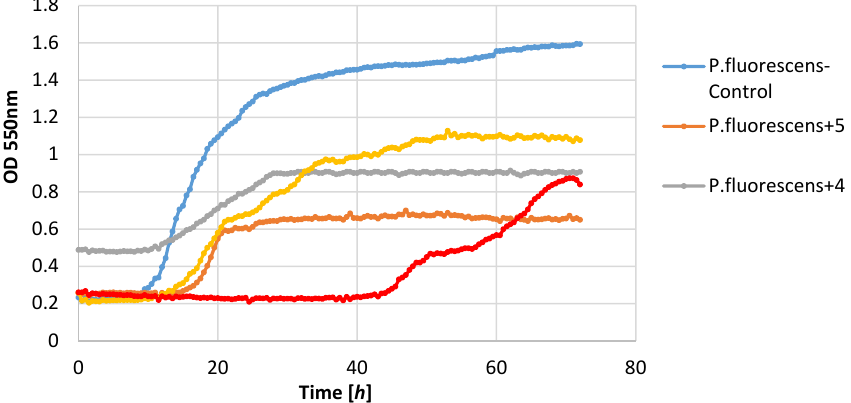
Figure 6. The assessment of the effects of the lactones 2 – 5 on the growth of P. fluorescens (OD-Optical Density was measured for λ 550 nm).